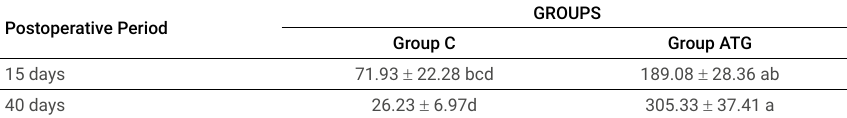
Table 2. Means and standard deviations of the number of Wnt10/ β + cells/mm 2 in both groups in each postoperative